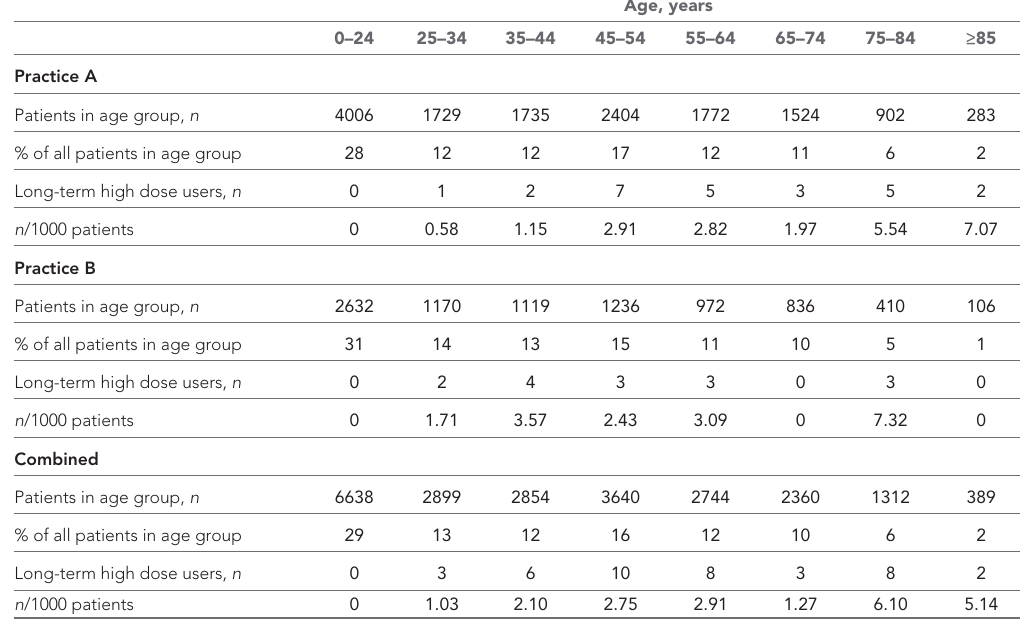
Table 4 Age profile of patients prescribed LTHD opioids in the two practices in the index week 2017